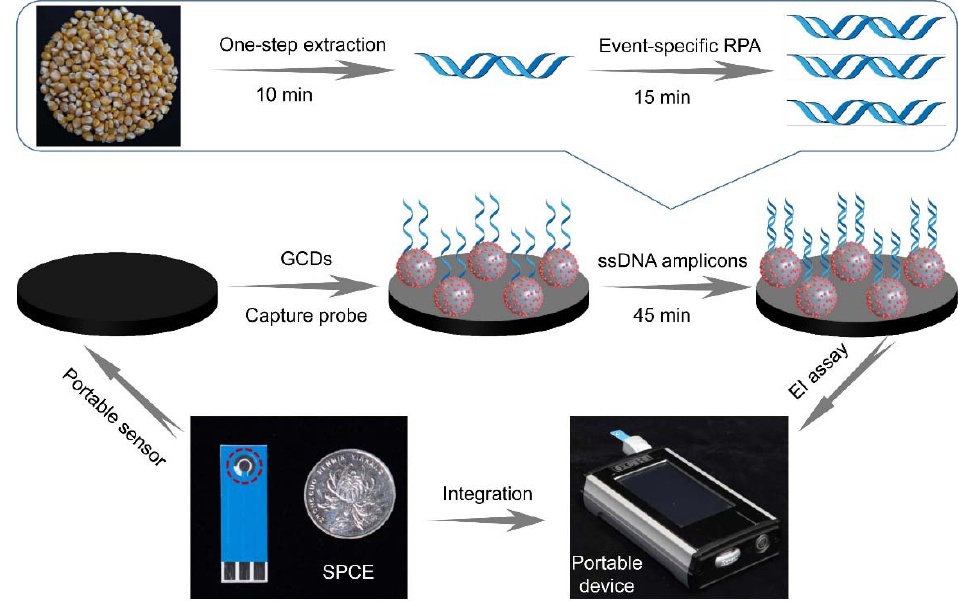
Figure 2. Schematic illustration of GCD-based EI genosensor coupled with one-step extraction and event-specific RPA for the identification of GM maize.